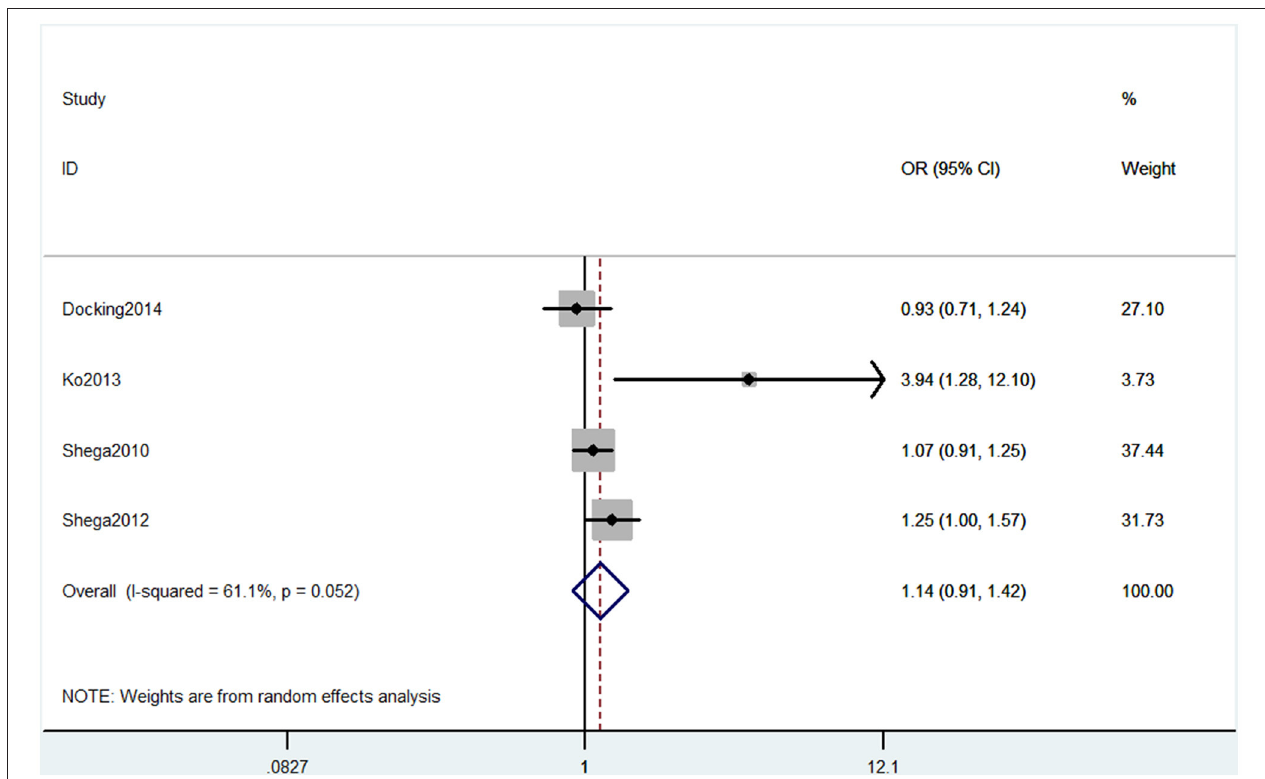
FIGURE 8 | Forest plot of the OR and 95% CI from a random-effects meta-analysis for the association between chronic pain and incidence of cognitive decline when MMSE binary method was used. The rhombi represent the pooled OR for this